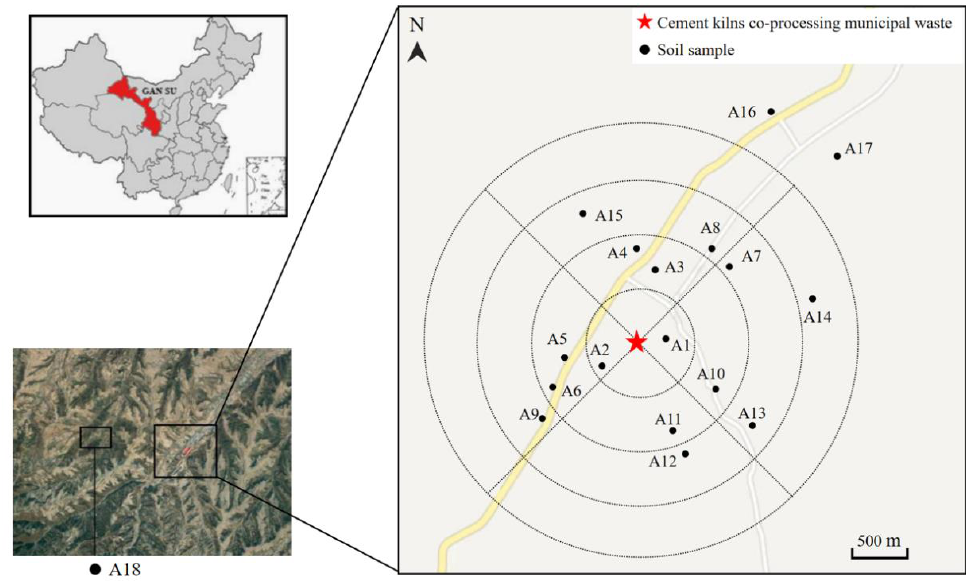
Figure 1. Map of the area investigated showing the soil sampling locations, where A18 denotes the background sample.